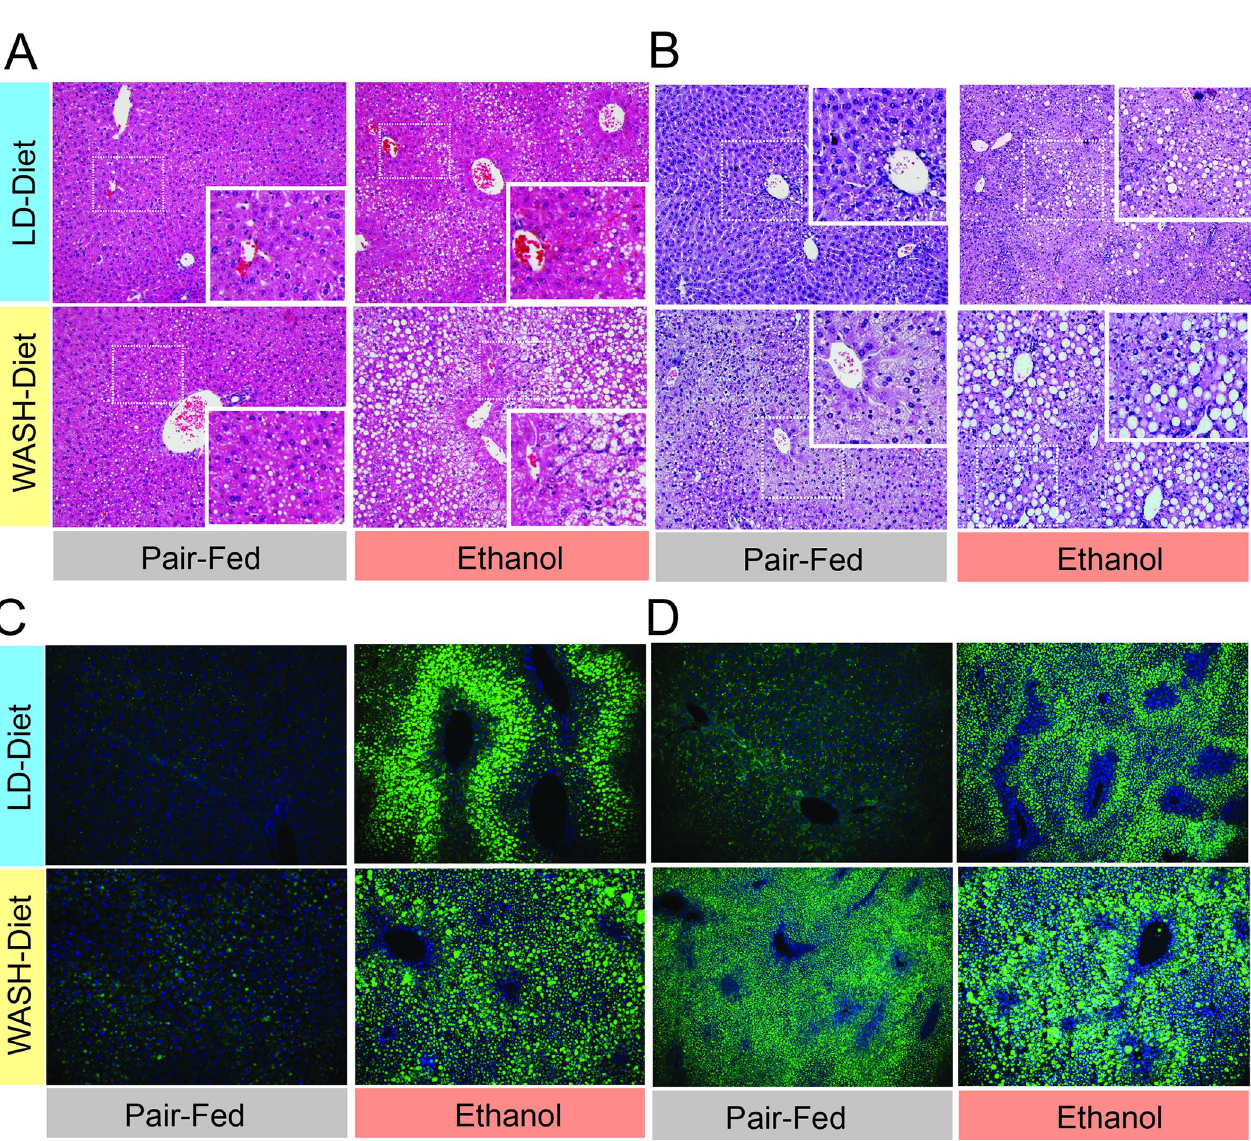
Fig 3. Hepatic lipid content is elevated in mice fed the WASH-ethanol diet. A. Hematoxylin and eosin (H&E) staining of liver sections from fed the LD and WASH diets +/- ethanol for 5 weeks B. 7 weeks C. BODIPY neutral lipid staining of liver samples from mice receiving the LD and WASH ethanol diet +/- ethanol for 5 or D. 7 weeks. Representative images from sections analyzed from 8 mice (n = 8). Left (H&E) or right (BODIPY) lateral lobes were stained as described in the materials and methods section.